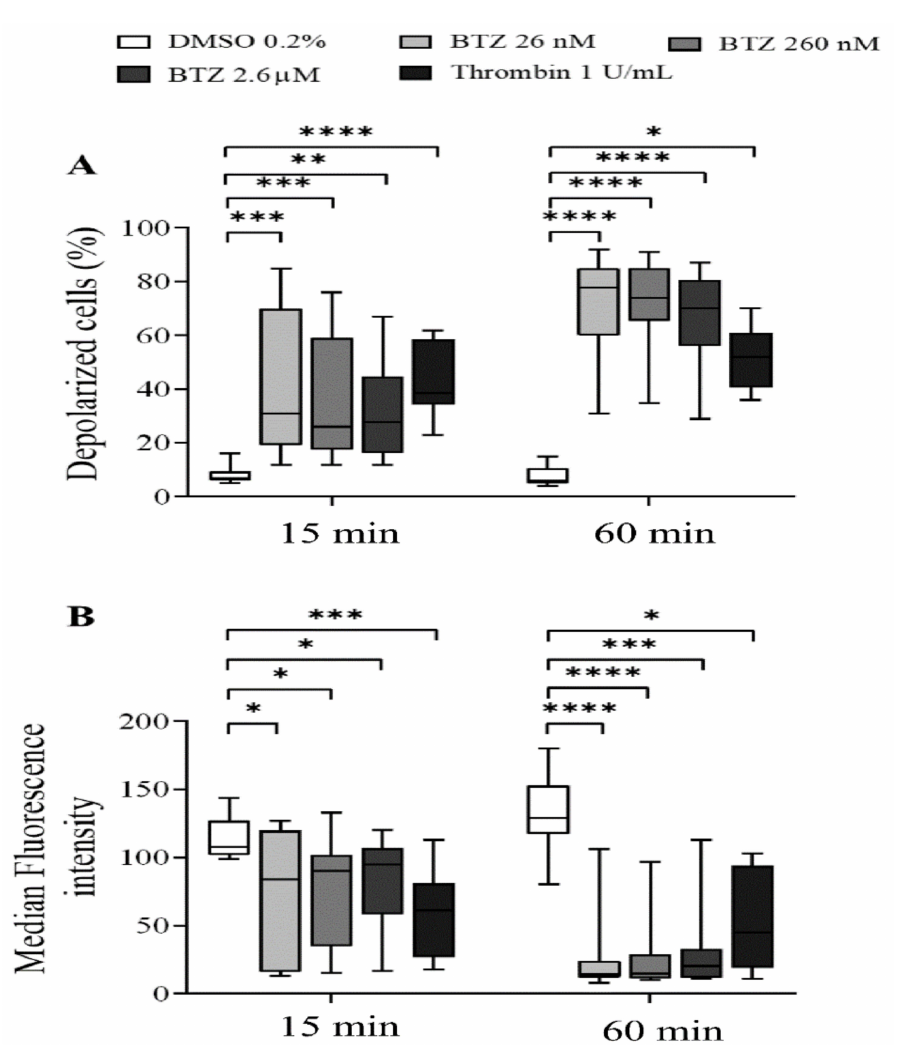
Figure 3. BTZ induces ∆Ψ m depolarization of human GFPs. GFPs were incubated with BTZ, thrombin (positive control) and DMSO (negative control) for 15 and 60 min. Depolarization of ∆Ψ m was analyzed by flow cytometry using DiOC 6 (3) dye. Data are expressed as median and interquartile range of the percentage of depolarized cells ( A ) and the median fluorescence intensity ( B ). The level of significance at both 15 and 60 min of treatment ( n = 12) was determined using the Kruskal–Wallis test and Dunn’s multiple comparisons test; * p < 0.05, ** p < 0.01, *** p < 0.001 and **** p < 0.0001 compared to the DMSO group. BTZ: bortezomib; DMSO: dimethyl